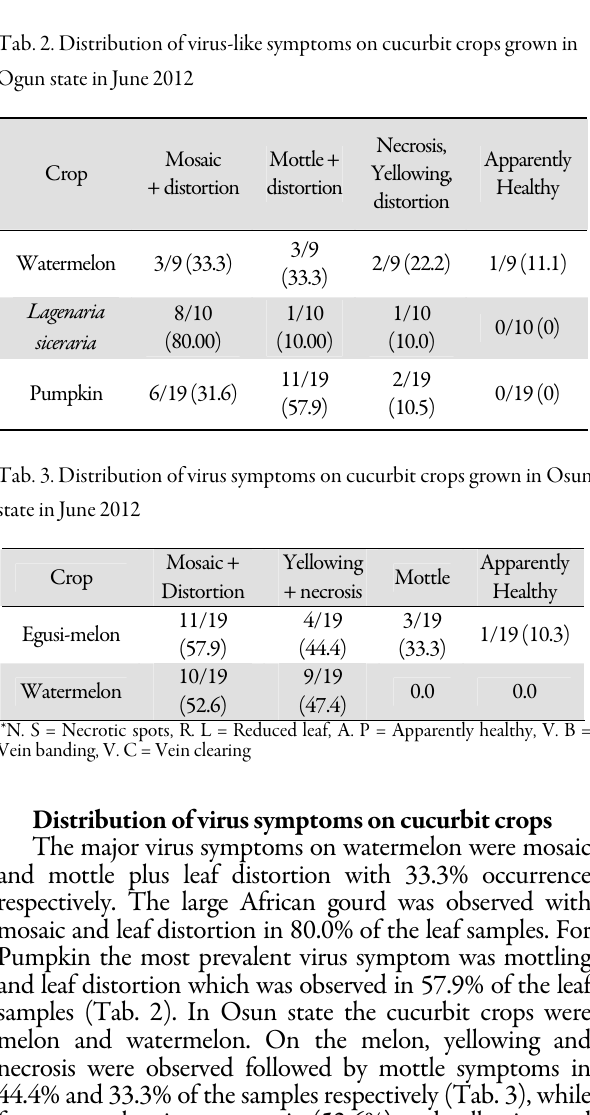
Mosaic + distortion